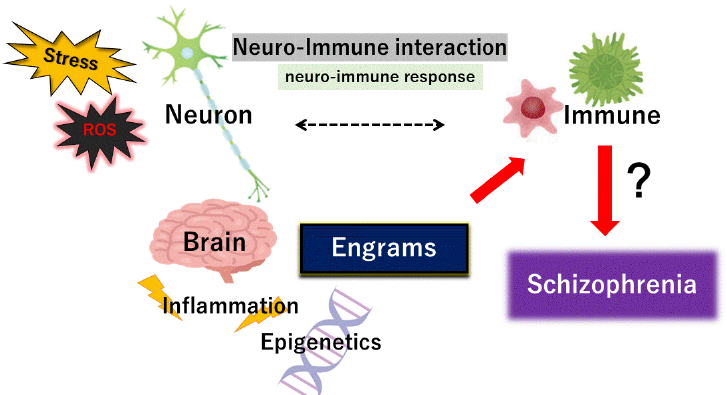
Figure 1. Schematic representation of the pivotal role of neuro-immune interaction including neuro-immune response during the pathogenesis of schizophrenia. The immune system is not self-regulated but interconnects in close relationship with the nervous system. Illustration of the pathogenic role of stress, ROS, inflammation, and engrams has also been shown. Note that some important events have been excluded for